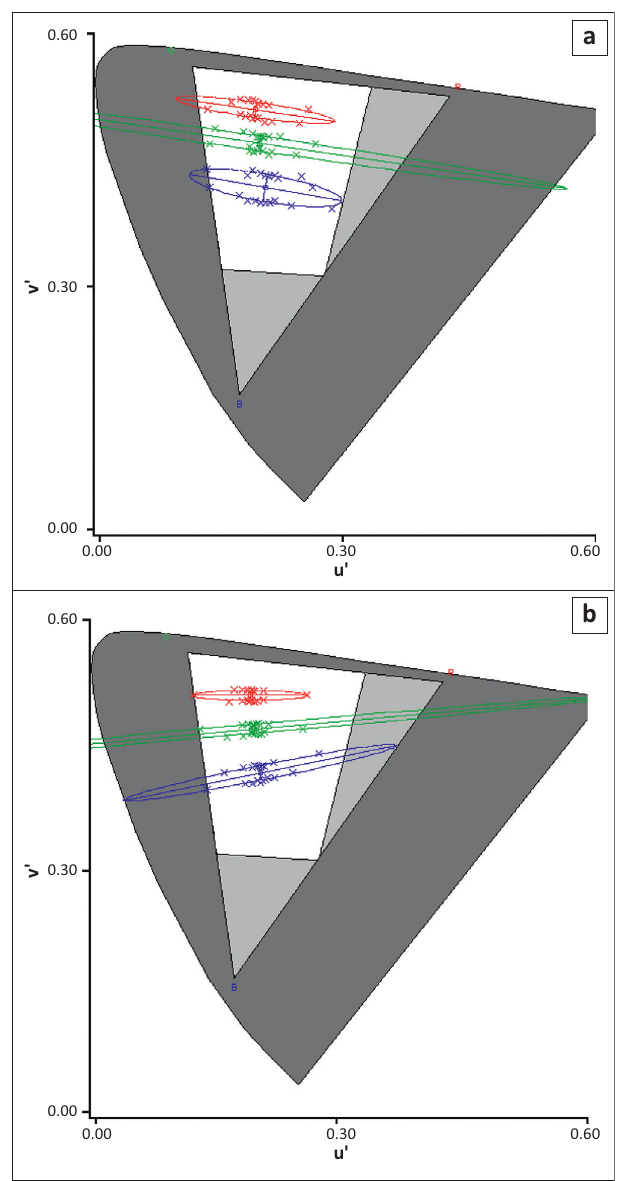
FIGURE 1: Ellipses test results from a deuteranope (a) showing a ‘top-left’ slant and (b) protanope showing a ‘bottom-left’ slant of the